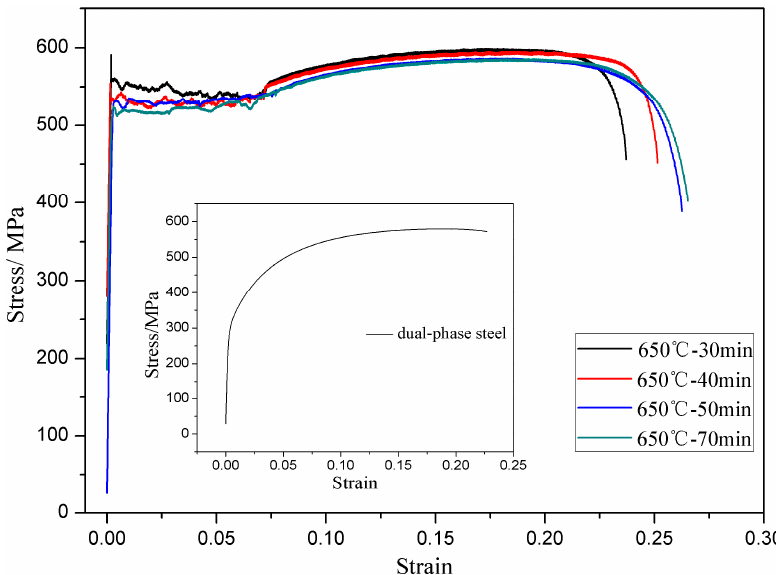
Figure 5. Stress-strain curves of the original dual-phase steel and the specimens annealed at 650 °C for different holding times.